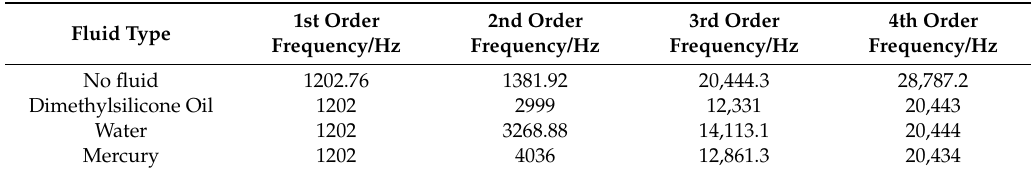
Table 2. The effect of different fluids on the coupling modal of the sensor.